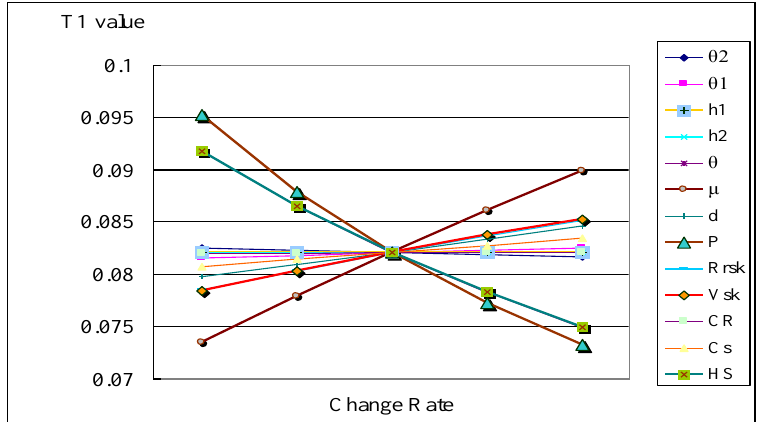
Figure 3. Sensitivity analysis for s when input parameters change.